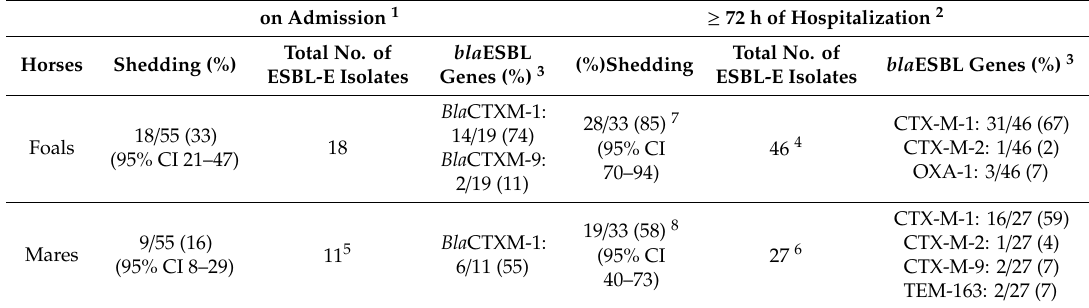
Table 2. Shedding rates of ESBL-E in mares and foals on admission and during hospitalization.